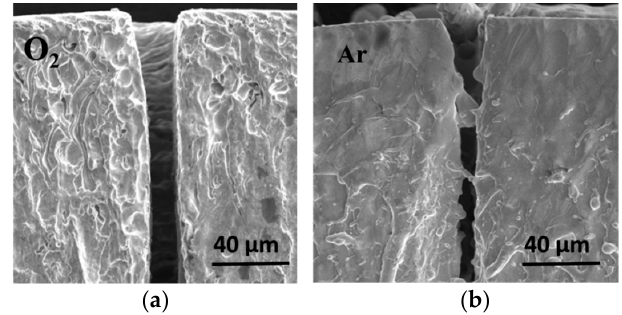
Figure 7. Kerf cross-sections of the cuts with the acid pickling process: ( a ) oxygen cut; and ( b ) argon cut. Unneat kerfs influence the stents’ dimension accuracy, as well as the surface quality. Dross